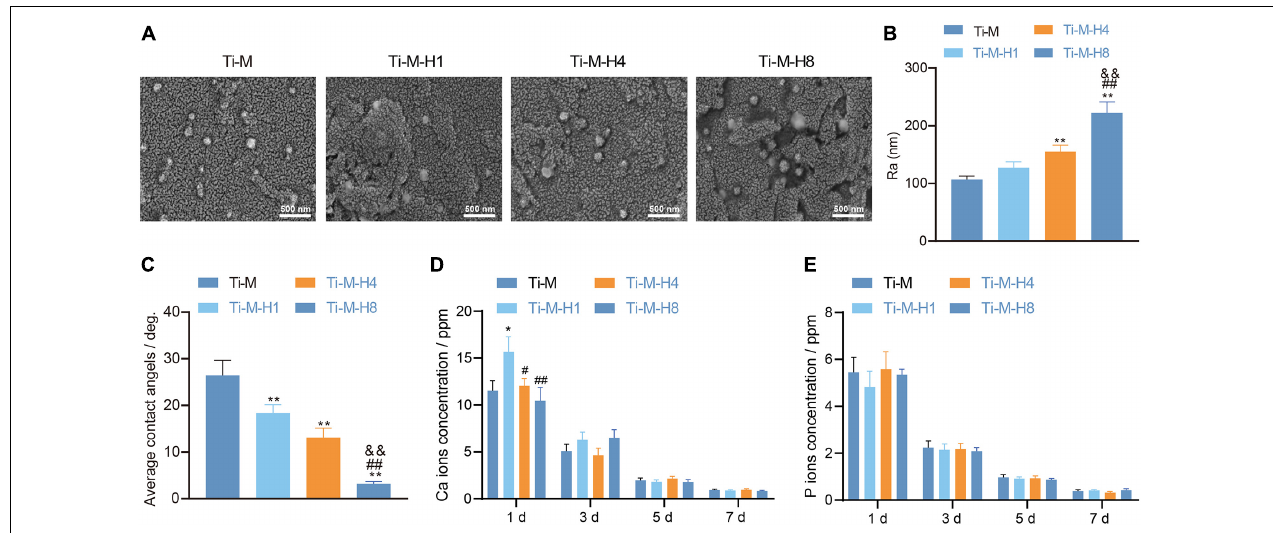
FIGURE 1 | Surface morphology and component characterization of Ti–M–H coatings. (A) Coating morphology via scanning electron microscopy. (B) Roughness analysis on the coating surface. (C) Sample surface wettability test. (D) Amount of Ca ion release after 1 day of immersion in phosphate-buffered saline. (E) The amount of P ion released after 1 day of immersion in PBS. * P < 0.05 compared with Ti–M. # P < 0.05 compared with Ti–M–H1. & P < 0.05 compared with Ti–M–H4. ** P < 0.01 compared with Ti–M. ## P < 0.01 compared with Ti–M–H1. && P < 0.01 compared with Ti–M–H4. The experiments were repeated three times.